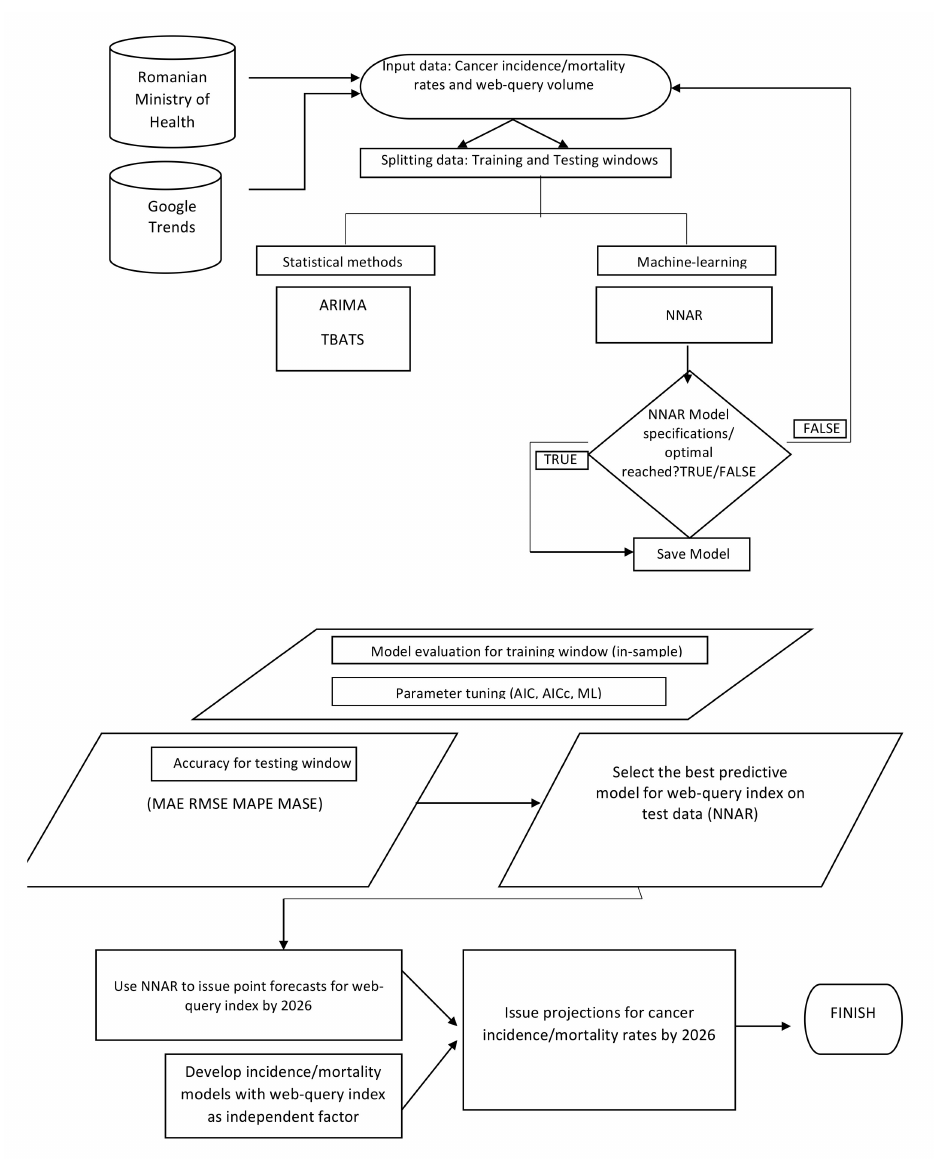
Figure 5. The integrated framework for modeling and forecasting cancer incidence and mortality